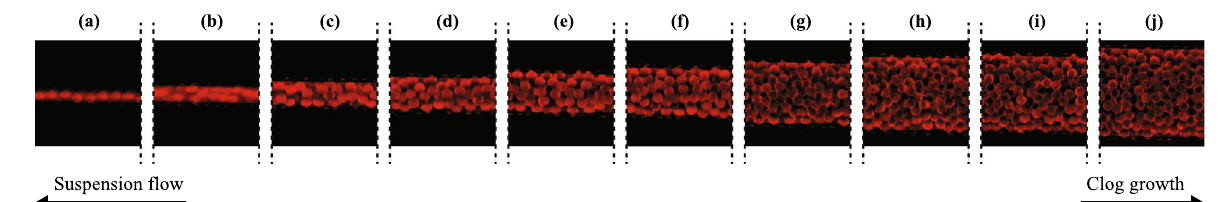
Figure 6. Micrographs showing sections of distinct clogs in a tapered channel, for (cid:31) P = 2000 mbar and φ = 0.05%. None of the clogs are connected, and the suspension medium is able to filter through the voids in the packed particles. In images ( a )–( j ) are clogs with 1–10 particles spanning the width of the constriction, respectively. Clogs are formed by sieving where w c / d p ≈ 1 , and by bridging mechanism in positions where w c / d p ≥ 2